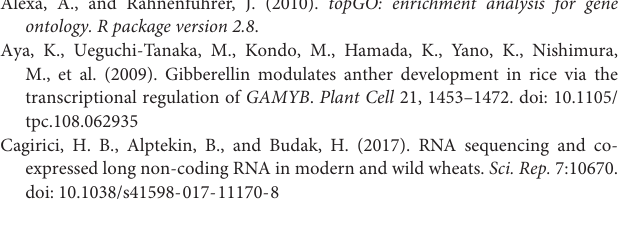
Supplementary Table 6 | The cis - and trans -target genes of the identified lncRNAs.